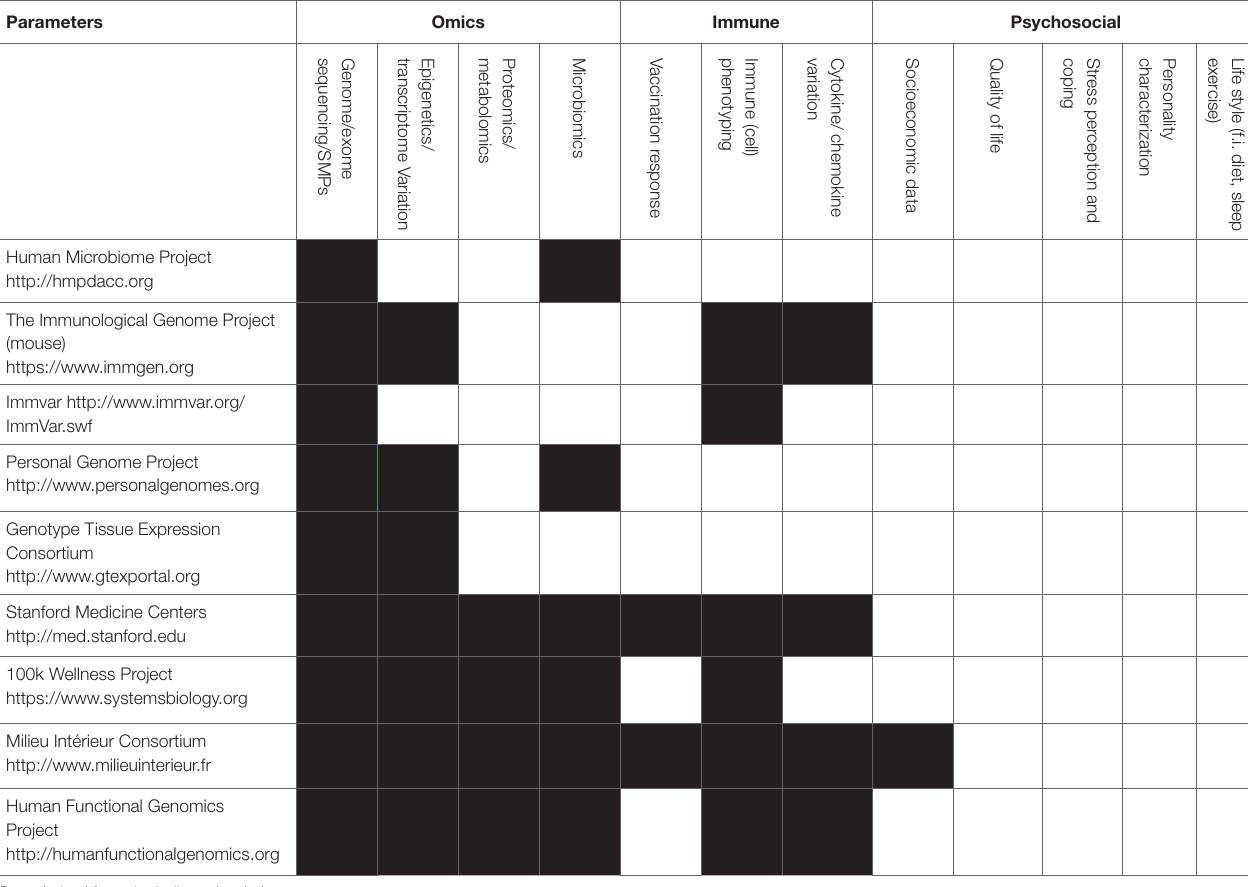
tABLe 1 | scope of consortia. Parameters Omics immune